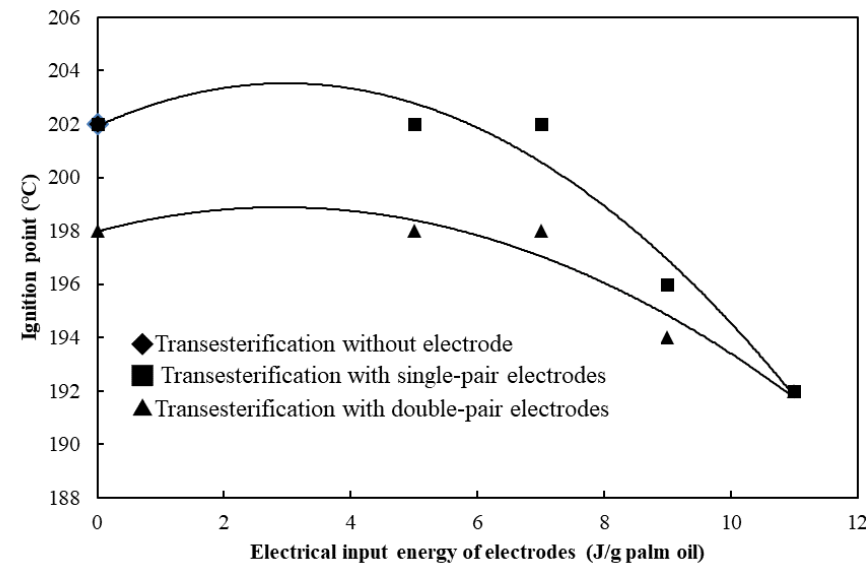
Figure 9. Effects of electrical energy input to electrodes for dissociating water on the ignition point of biodiesel product.